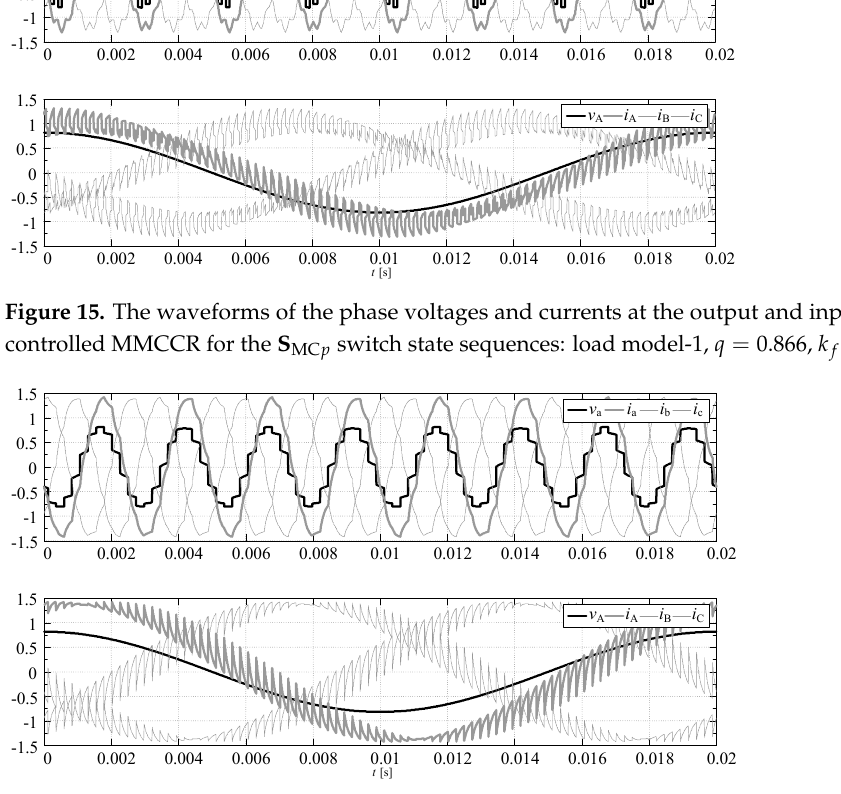
Figure 16. The waveforms of the phase voltages and currents at the output and input of the PWR controlled MMCCR for the S MC p switch state sequences: load model-1, q = 1.0, k f = 8.